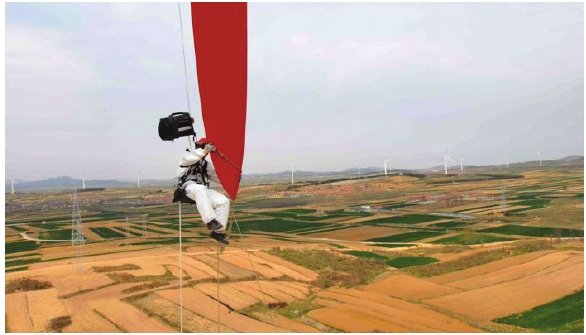
Figure 1. Inspection of a wind turbine conducted using the rope descendent technique (Nurm,